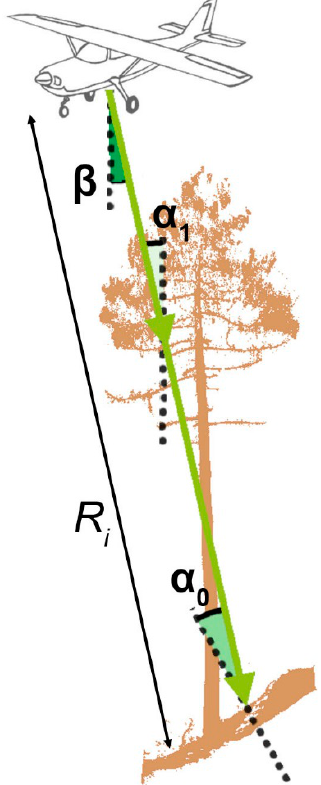
Figure 2. Relation between the angle of incidence at the ground ( α 0 ) and at a branch ( α 1 ), the scan angle ( β ), and the range from the sensor to ALS FW return corresponding with the ground ( R i